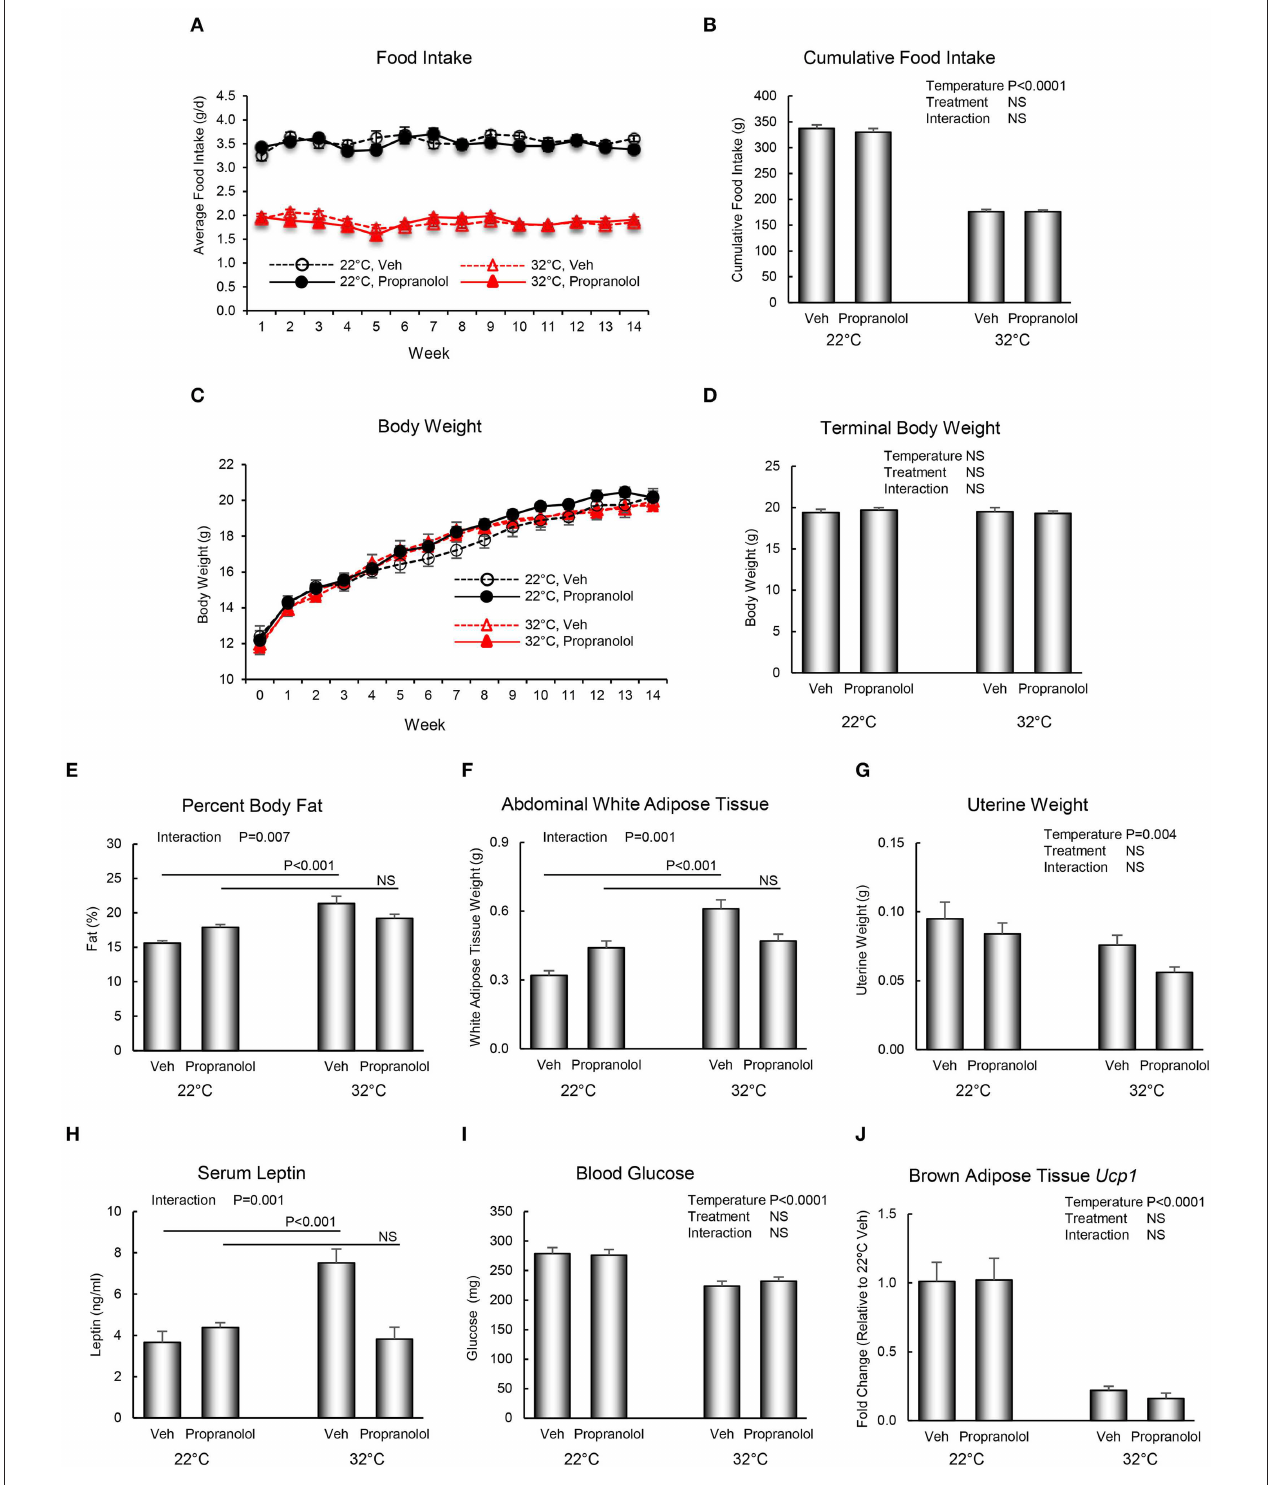
FIGURE 2 | Effect of housing temperature (temperature) and treatment with propranolol (treatment) on (A,B) food intake, (C,D) body weight, (E) percent body fat, (F) abdominal white adipose tissue weight, (G) uterine weight, (H) serum leptin, (I) blood glucose, and (J) brown adipose tissue Ucp1 gene expression. Data are mean ± SE. N = 10/group for (A–I) and n = 8/group for (J) . Post–hoc analysis was performed when there was a significant interaction term.